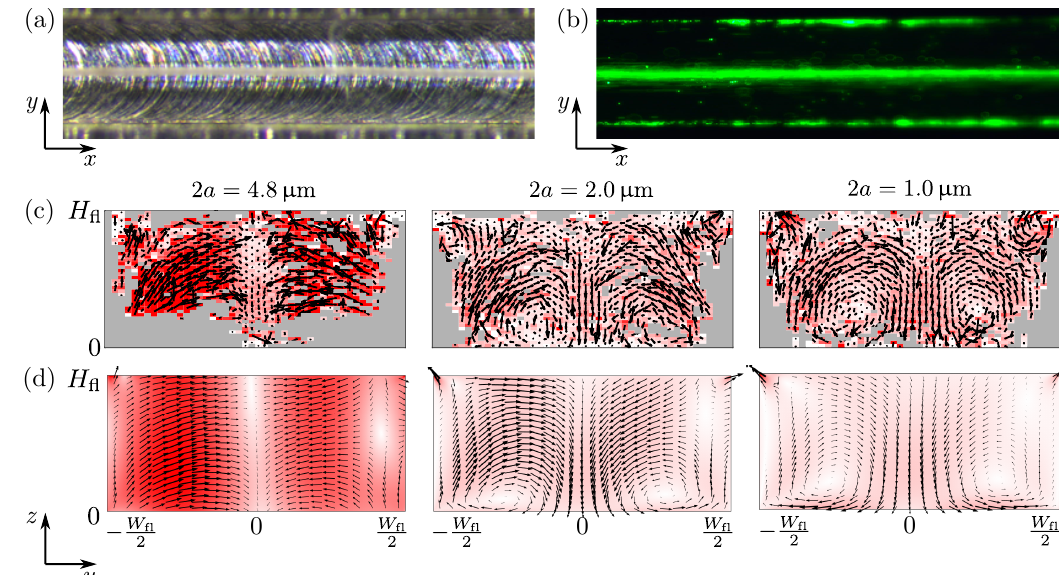
Figure 3. ( a ) Bright-field micrograph under flow-through condition showing acoustophoretic focusing of 4.8-µm-diameter polystyrene particles at the center (gray band). ( b ) Similarly for fluorescently-marked particles, but now also revealing that some particles are accumulating at the upper corners of the channel. ( c ) Vector plot (black arrows) and color plot ranging from 0 µm/s (white) up to 40 µm/s (red) of the particle velocities v pa in the vertical cross section measured by GDPT at resonance mode “S”, f = 2.048 MHz, for different particle diameter 2 a = 4.8 µm, 2.0 µm, and 1.0 µm. ( d ) Same vector and color plot as (c) but for the simulated results of v pa in the 2D geometry shown in Figure 1b at the numerically determined resonance frequency f = 1.803 MHz (12% lower).